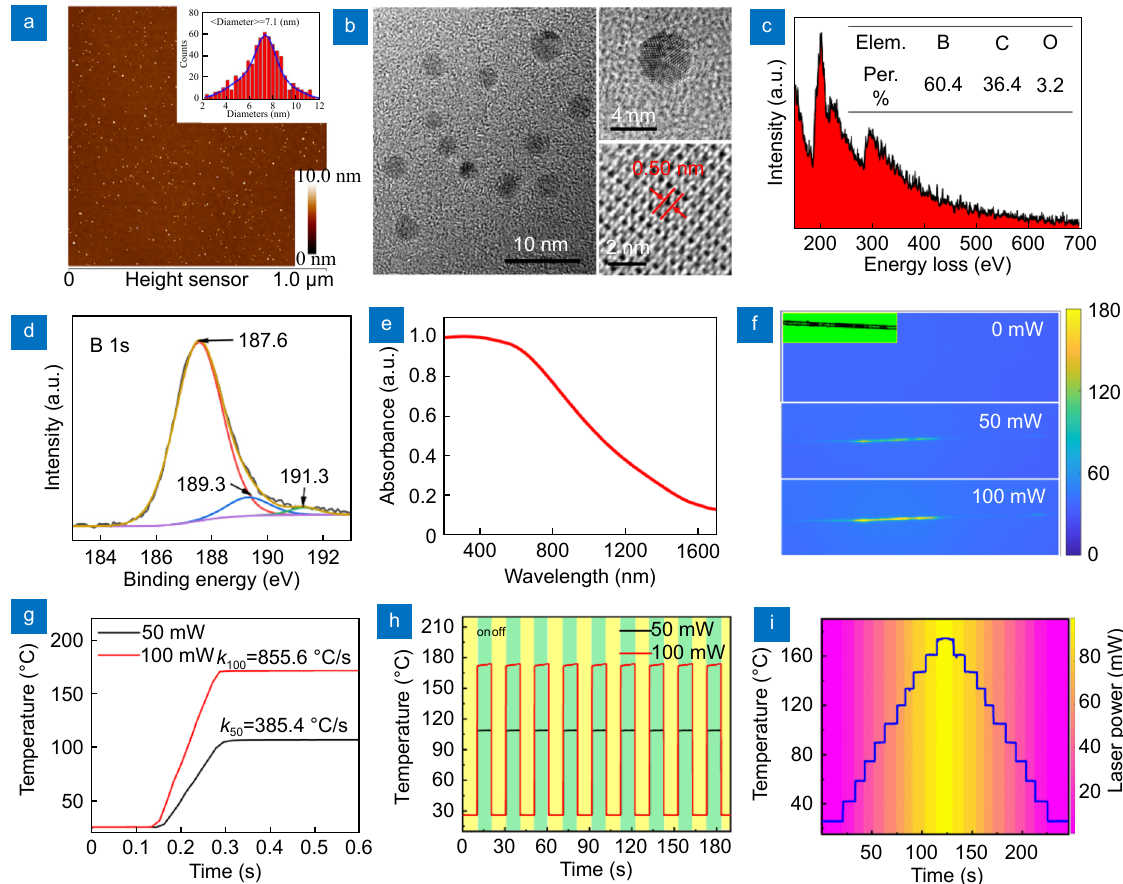
Fig. 1 | Characterization and photothermal properties of BQDs. ( a ) AFM image with statistical data of diameters (inset). ( b ) HRTEM micro- graphs. ( c ) EELS spectrum with the corresponding atomic ratio. ( d ) XPS spectrum of B 1s. ( e ) UV-Vis-NIR absorption spectrum. ( f ) IR thermo- gram of the BQDs-deposited microfiber with the incident light power of 0 mW, 50 mW and 100 mW, respectively, inset shows the optical micro- scopic image of BQDs-deposited microfiber. ( g ) Photothermal response rate at 50 mW and 100 mW. ( h ) Photothermal switching performance at 50 mW and 100 mW. ( i ) Temperature variation with light power from 0 to 100 mW with an interval of 10